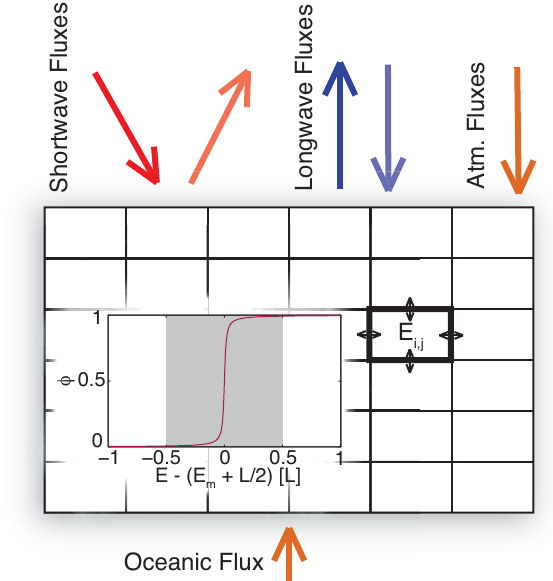
Fig. 1. The thin vertical ice-ocean layer is modeled by a regular network of diffusively interacting ice-ocean cells. The state of each cell is given by its energy content E i,j , which also defines the phase of the cell (ice, water). Each cell can exchange energy with its near- est neighbors via state-dependent nonlinear diffusion. Atmospheric heat fluxes are entering at the upper surface (top row), and oceanic heat fluxes are entering at the bottom row of the ice-ocean layer. The inset shows the steplike phase transition between ice (φ = 0 ) and water (φ = 1 ) and the gradual release of latent heat L as the energy of a cell increases (shaded